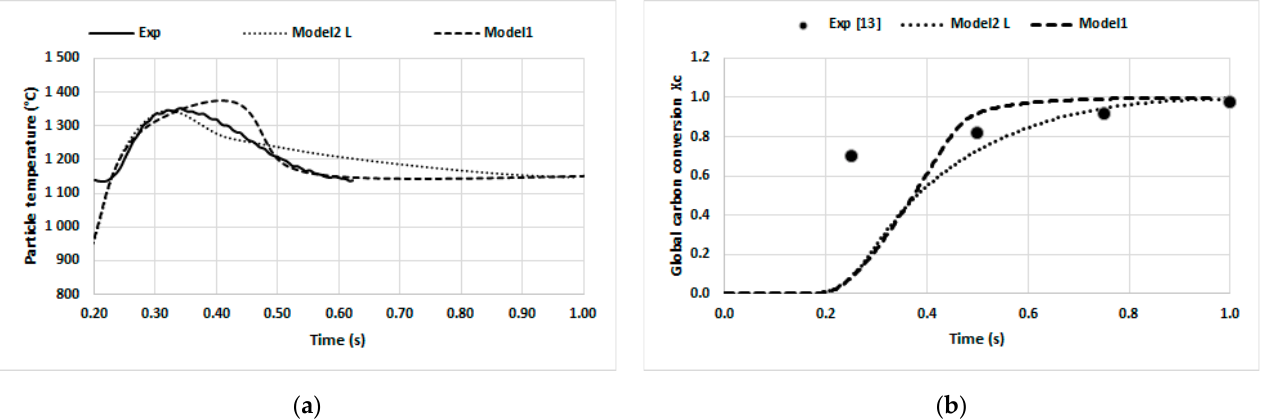
Figure 6. Comparison of the particle temperature ( a ) and of the global carbon conversion ( b ), returned by the present model (called Model2 L, dotted line) with Laurendeau’s equation and the previous model (called Modell, hyphened line). The experimental particle temperature is represented with a solid line in Figure 6a. The black points in Figure 6b correspond to experimental values taken from [13]. Regulation temperature of the reactor equal to 1200 ◦